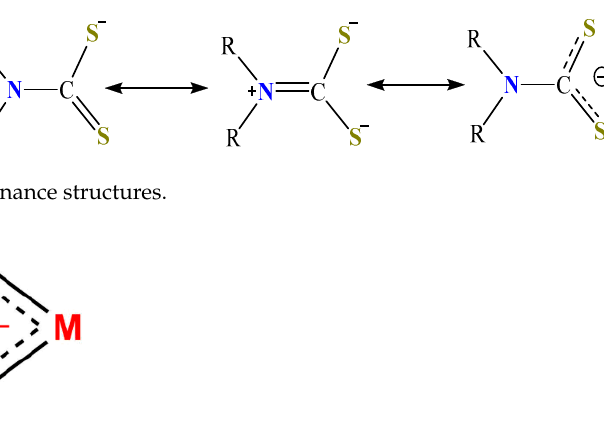
Figure 2. π -electrons delocalization through N-CS 2 group.